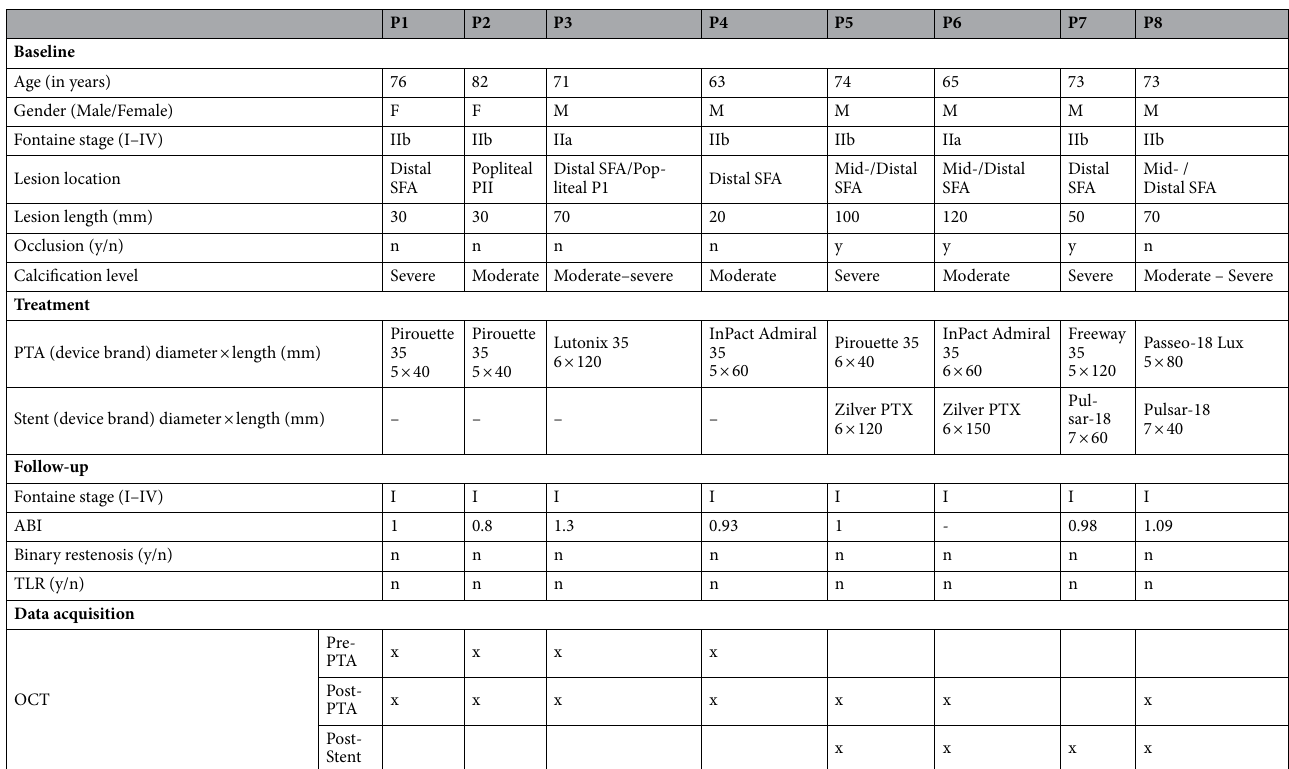
Table 1. Patient demographics, lesion characteristics, treatment methods, clinical outcomes at a 1-year follow-up, and the time points, when OCT and DUS were performed. SFA superficial femoral artery,